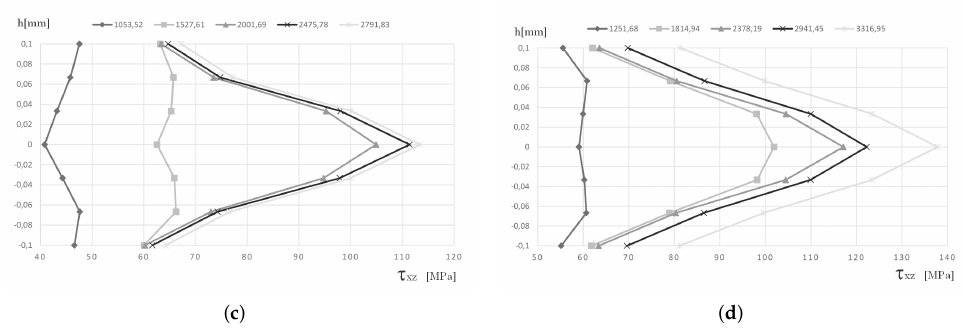
Figure 9. Stress distribution along the thickness in line D-D’ for the clamped. FEM analysis ( a ) σ xx and ( c ) τ xz . RPIM analysis ( b ) σ xx and ( d ) τ xz . Load increments in [kN/m 2